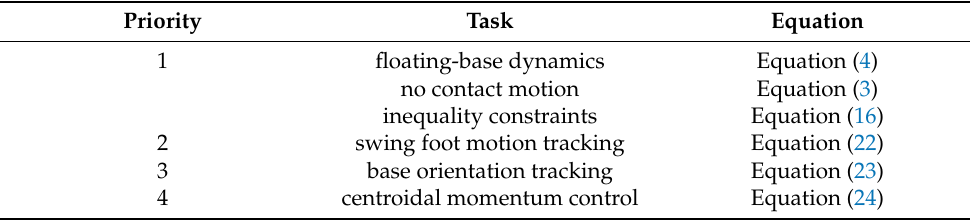
Table 2. The task priorities used in the loco-manipulation mode of the HQP (1 is the highest priority). Priority Task Equation 1 floating-base dynamics Equation (4) no contact motion Equation (3) inequality constraints Equation (16) 2 swing foot motion tracking Equation (22) 3 base orientation tracking Equation (23) 4 centroidal momentum control Equation